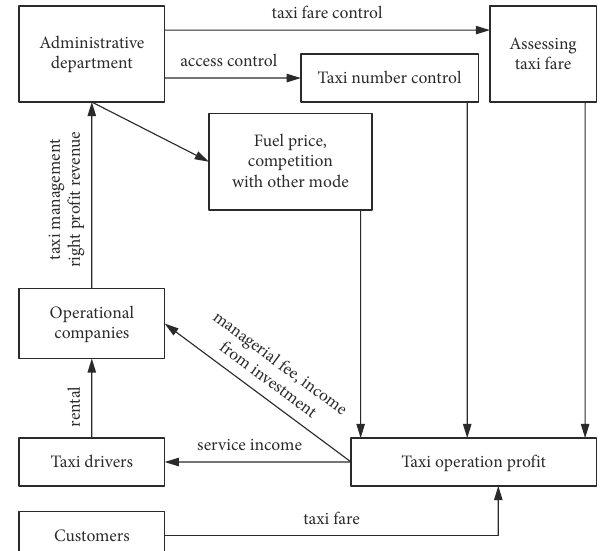
Figure 1. Urban taxi market benefits distribution